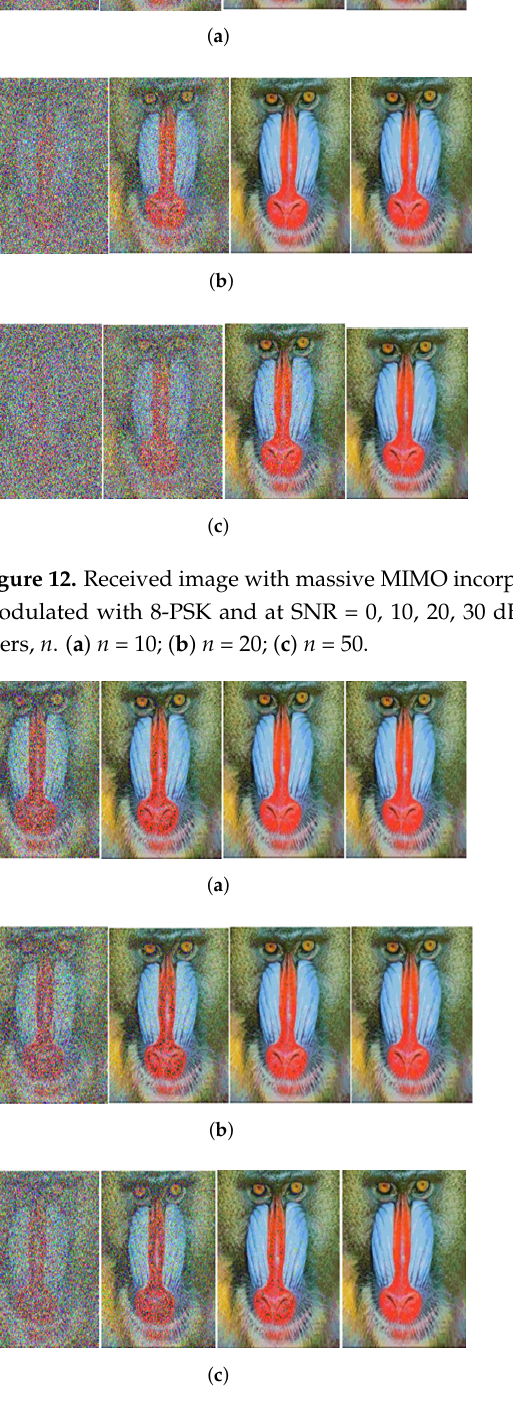
Figure 13. Received image with massive MIMO incorporated FRFT-OFDM over a Rayleigh channel, Modulated with 16-PSK and at SNR = 0, 10, 20, 30 dB from Left to Right for different number of users, n . ( a ) n = 10; ( b ) n = 20; ( c ) n =